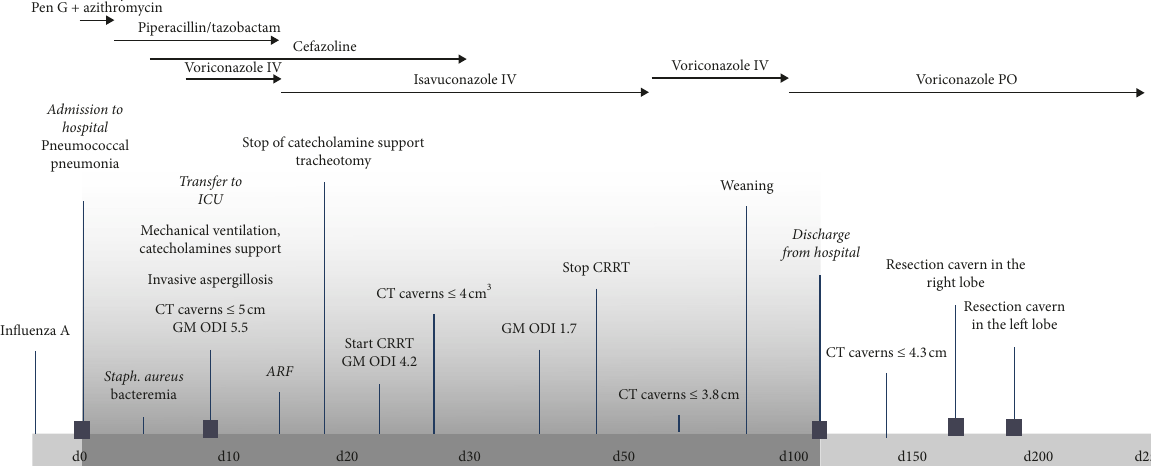
Figure 2: Summary of patient’s history with given antimicrobial therapy. ICU: intensive care unit; GM: galactomannan; ARF: acute renal failure; CRRT: continuous renal replacement